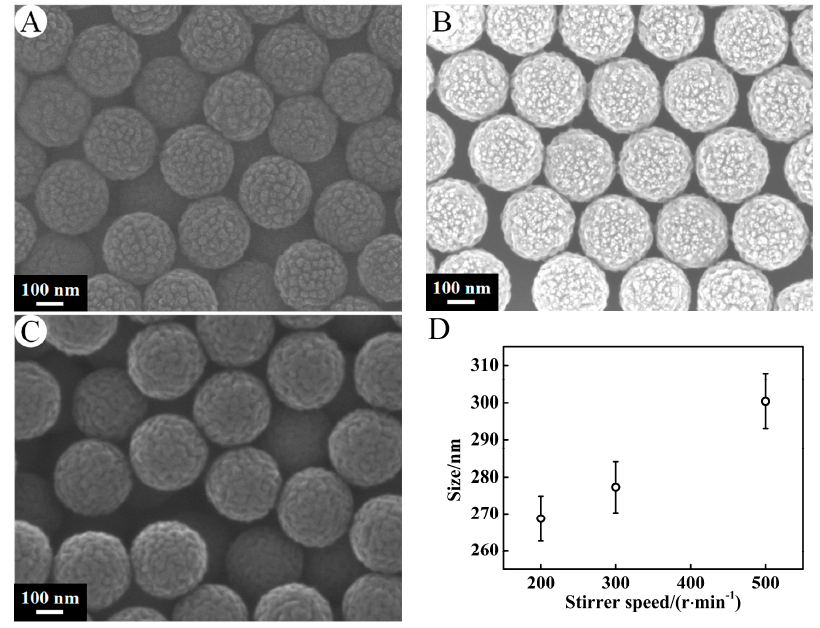
Figure 6. SEM micrographs of PSA nanospheres under preparation conditions of the stirrer speed ( A ) 200 r·min − 1 , ( B ) 300 r·min − 1 , ( C ) 500 r·min − 1 . Other conditions: AA, 0.3 g; St, 6 g; KPS, 0.24 g. Effects of